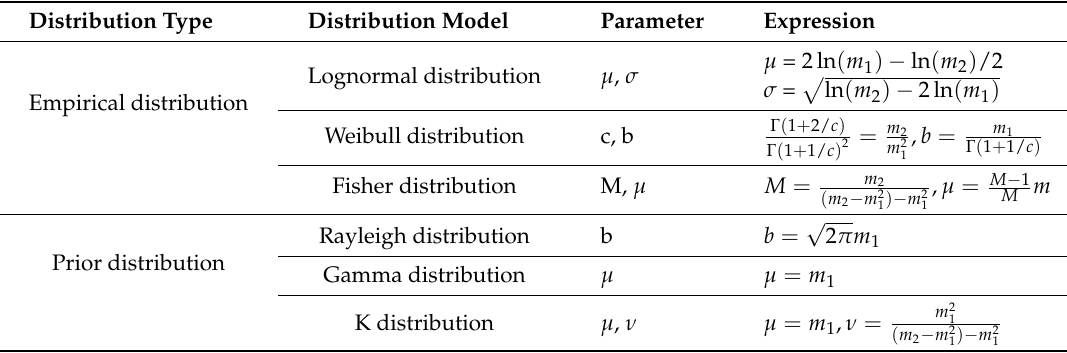
Table 1. Summary table of SAR image parameter